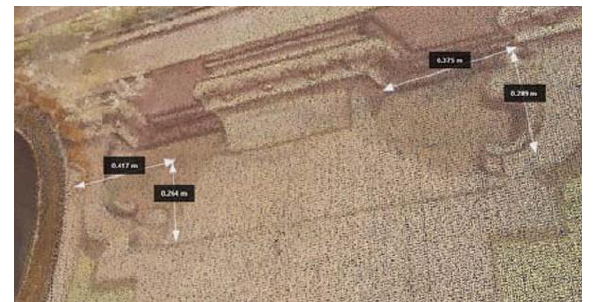
Figure 8. DEM three-dimensional view - 3d model of the vault elaborated with laser scanning